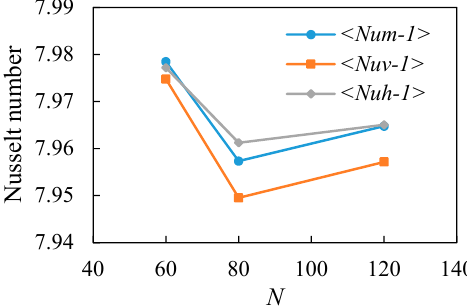
Figure 6. Dependency of time-mean averaged Nusselt numbers, < Nu m >, < Nu v >, and < Nu h > to grid number, N , at Pr = 0.025, κ = 0.5, Ra = 10 7 , and Ha = 0.